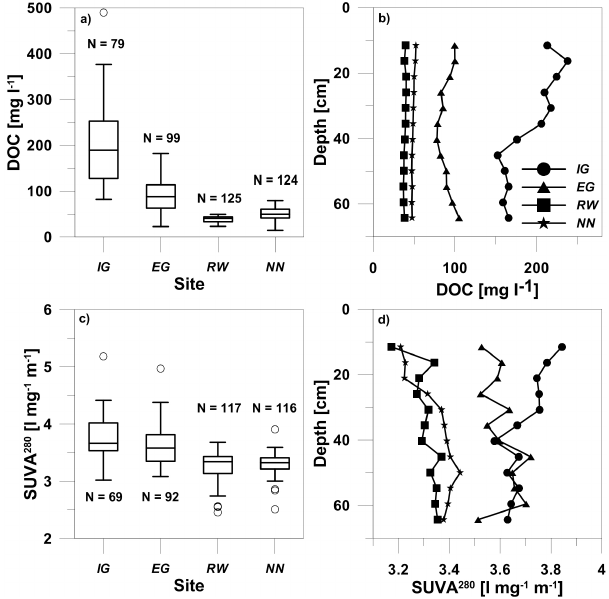
Fig. 5. Left: concentrations of (a) DOC-concentrations and (c) SUVA 280 at the study sites in the bulk samples (central crossbars represent the median, the boxes–the 75th and 25th percentile and the circles–extreme values). Right: vertical profiles of mean (b) DOC concentrations and (d) SUVA 280